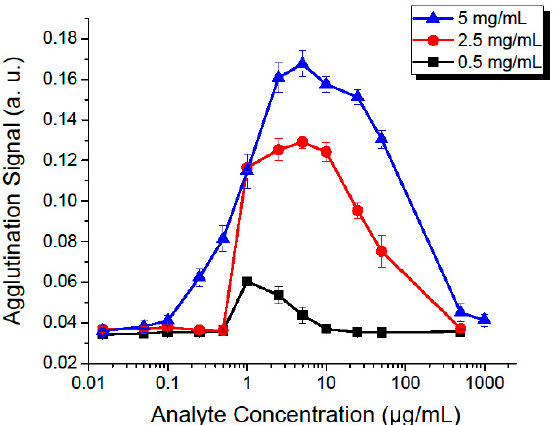
Figure 5. Effect of increasing the microbead and analyte concentrations, at a fixed flow rate of 175 µL/min, with an incubation time of 150 s. Each point represents repetitions of five experiments, with error bars showing the standard deviation between them. Each curve was made with a different concentration of microbeads, from 0.5–5